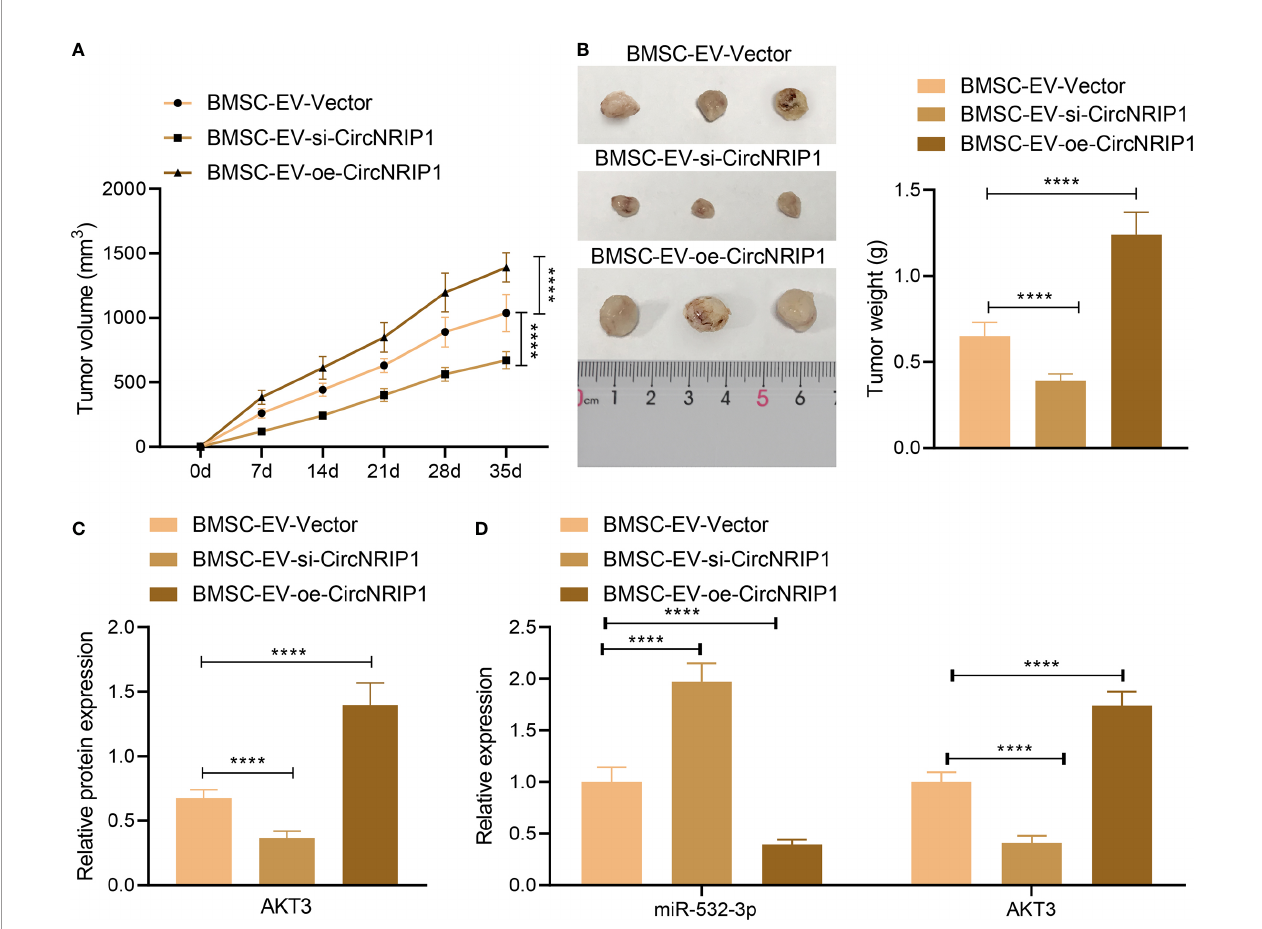
FIGURE 7 | circNRIP1 boosts the growth of tumors in vivo. (A) Quanti fi cation of tumor volume of mice treated with si-circNRIP1 or oe-circNRIP1 for 5 weeks. (B) Tumor weight of mice treated with si-circNRIP1 or oe-circNRIP1 measured after euthanasia. (C) Western blot analysis of AKT3 protein in tumor tissues of mice treated with si-circNRIP1 or oe-circNRIP1. (D) Expression of AKT3 and miR-532-3p determined by RT-qPCR in tumor tissues of mice treated with si-circNRIP1 or oe-circNRIP1. N = 8 for mice following each treatment. **** p < 0.0001. Data are shown as mean ± standard deviation of three technical replicates. Data among multiple groups were compared with one-way ANOVA, followed by Tukey ’ s post hoc tests. The repeated measures ANOVA with Bonferroni post hoc test was applied for the comparison of data at different time